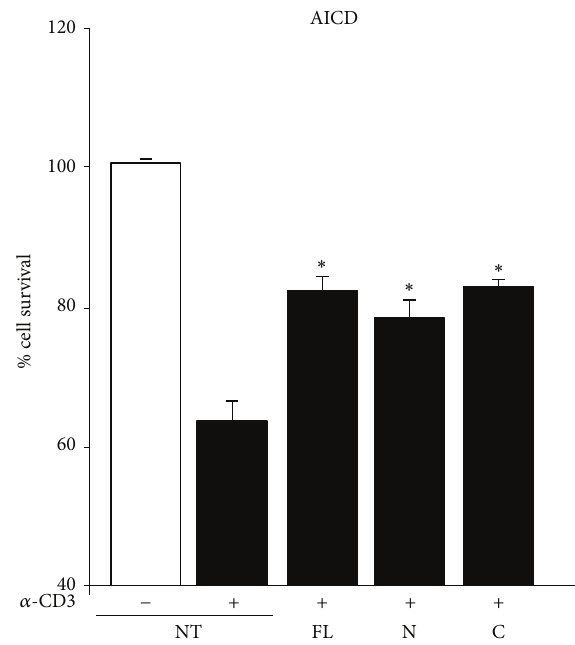
Figure 3: Effect of OPN variants on AICD of T cells. AICD was induced in PHA-derived T cell lines from healthy controls in the presence/absence of anti-CD3 and OPN variants. Results are expressed as relative cell survival % and are the mean ± SEM from 6 experiments. ( ∗ 𝑝 < 0.05 versus the control; Wilcoxon’s signed rank